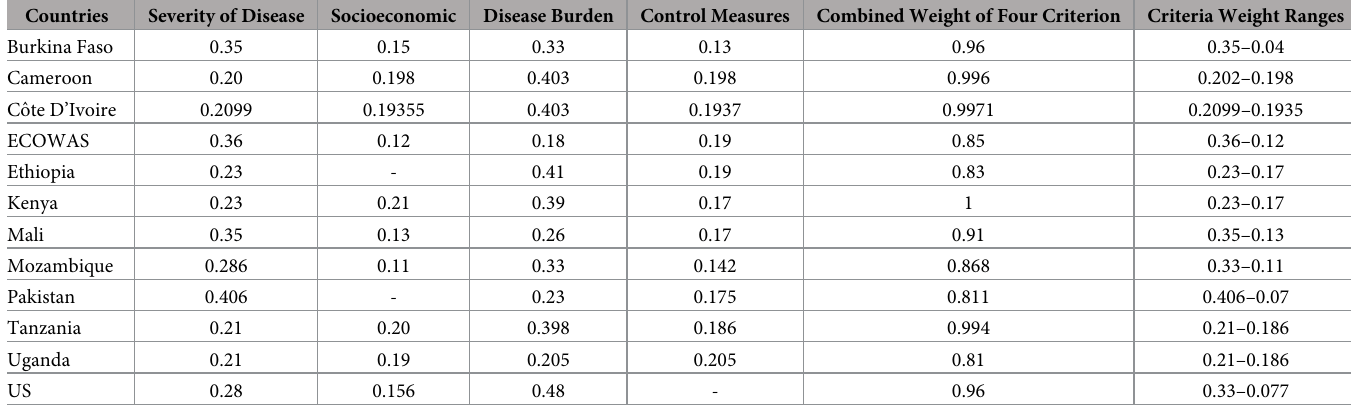
Table 2. Individual criteria contribution to total weight.